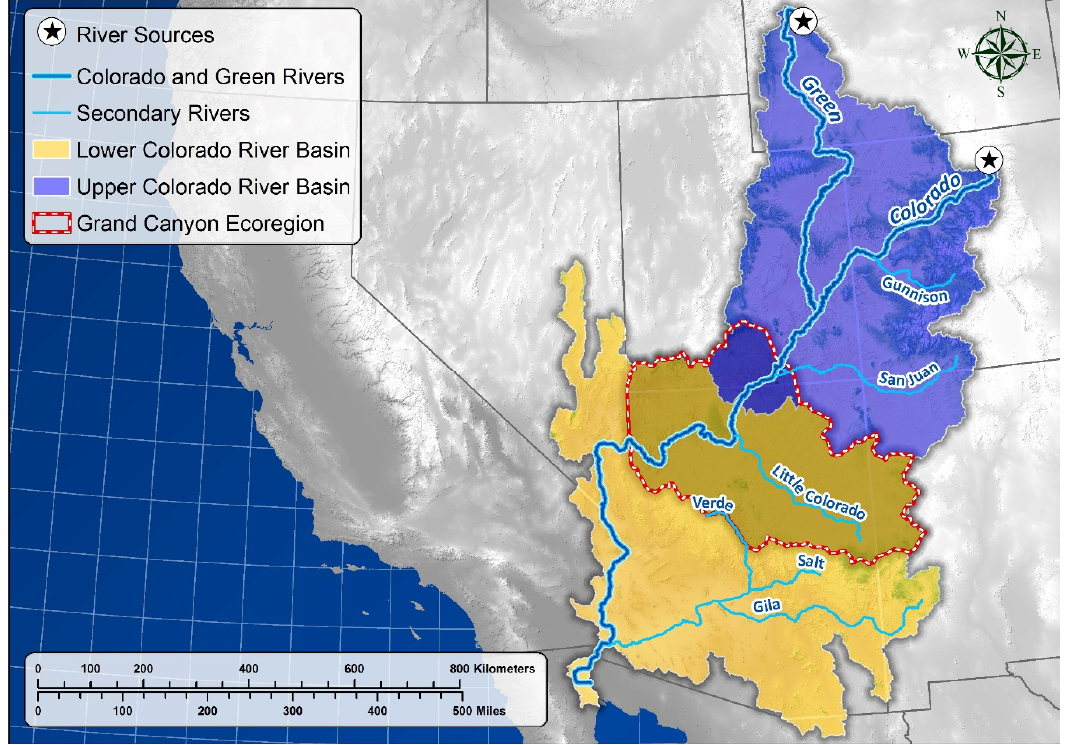
Figure 1. General map of the Colorado River Basin, depicting the Upper and Lower Basins, and the Grand Canyon ecoregion.